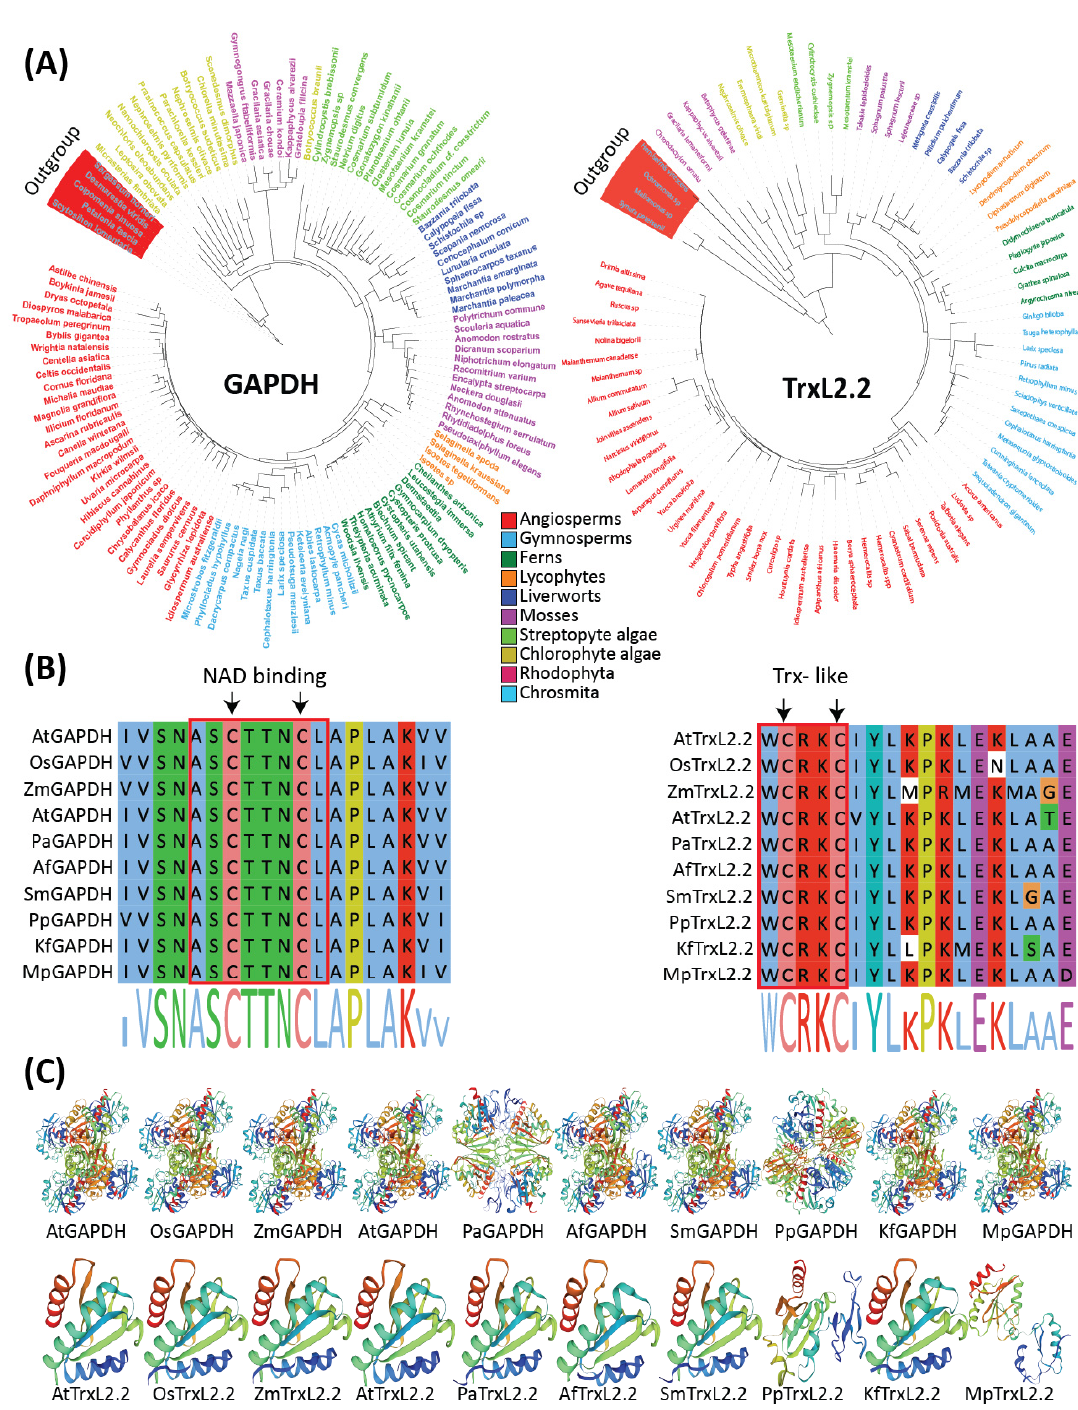
50%. Heat map was generated using TBtools [85] from the data of seven photosynthesis-related proteins and four redox-related families. Black squares indicate the proteins that do not satisfy the selection criteria. ACHTs: atypical Cys His-rich, CF1-y: gamma subunit of ATP synthase; CP12; FBPase: fructose-1,6-bisphosphatase; GADPH: glyceraldehyde-3-phosphate dehydrogenase; NADP-MDH: NADP + dependent malate dehydrogenase; RCA: ribulose-1,5-bisphosphate carbox-